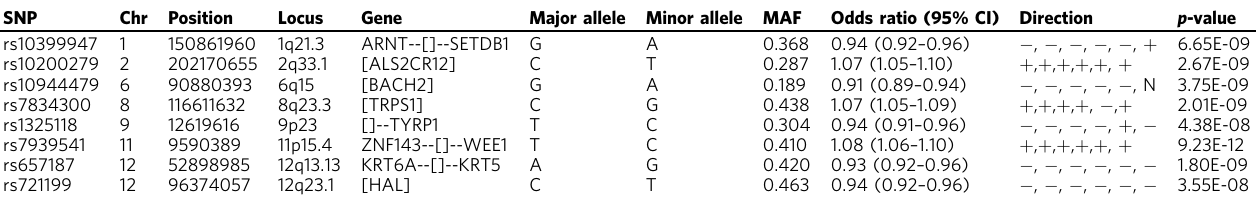
MAF: minor allele frequency, CI: con fi dence interval, build GRCh37. [] represents location of SNP either in relationship to known genes with [gene] indicating SNP is within the gene and gene — [] — indicating intergenic SNPs. Minor allele is effect allele. Minor allele frequency (MAF) is based on the pooled meta-analysis. Direction is listed in order for 23me, deCODE, NHS/HPFS, Kaiser, Ohio, and Rotterdam. N means not included in